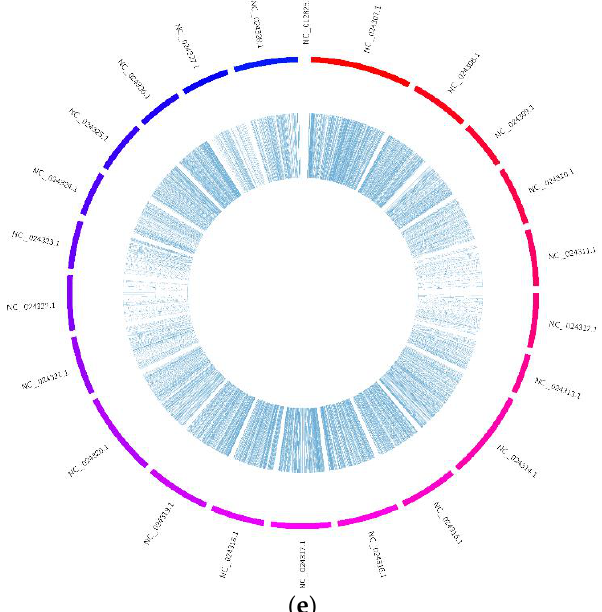
Figure 1. Statistics of circRNA. ( a ) Venn diagram of circRNAs distributed in different tissues, brain (B), pituitary (P), liver (L) and ovary (O). ( b ) The type of circRNAs. ( c ) The length of total circRNAs. ( d ) The number of back-spliced reads of circRNAs. ( e ) Distribution of circRNAs in different chromosomes.